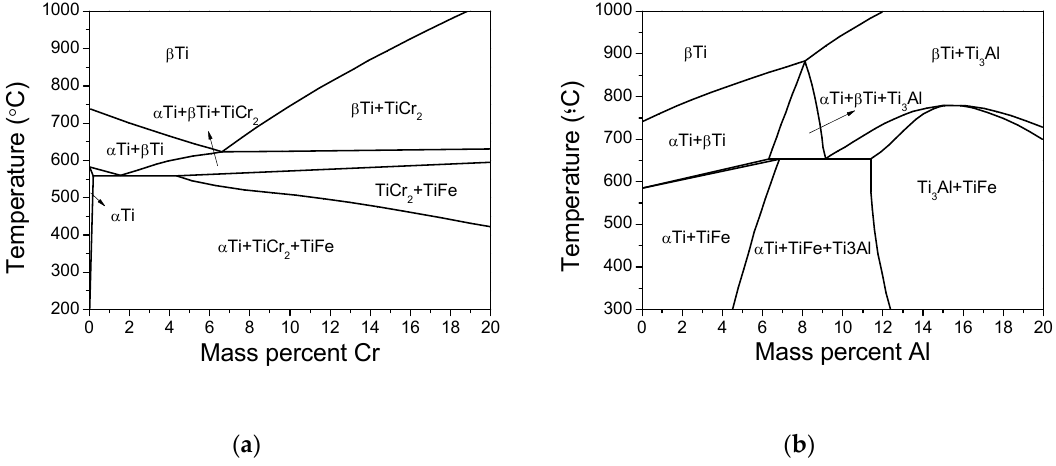
Figure 2. ThermoCalc [18] equilibrium phase diagrams ( a ) Ti ‐ 7Fe ‐ yCr ( b ) Ti ‐ 7Fe ‐ xAl .